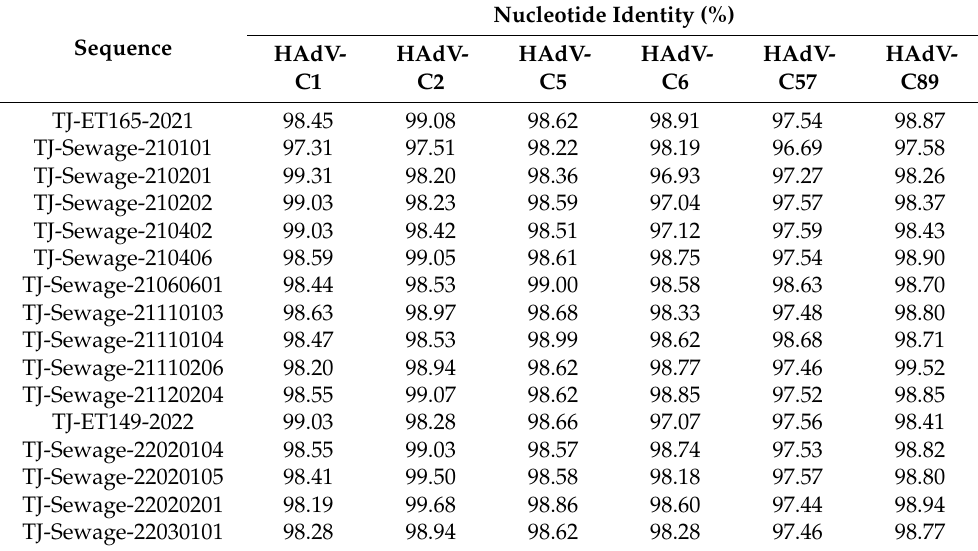
Table 2. The nucleotide identities between 16 Tianjin strains and HAdV-C representative strains.